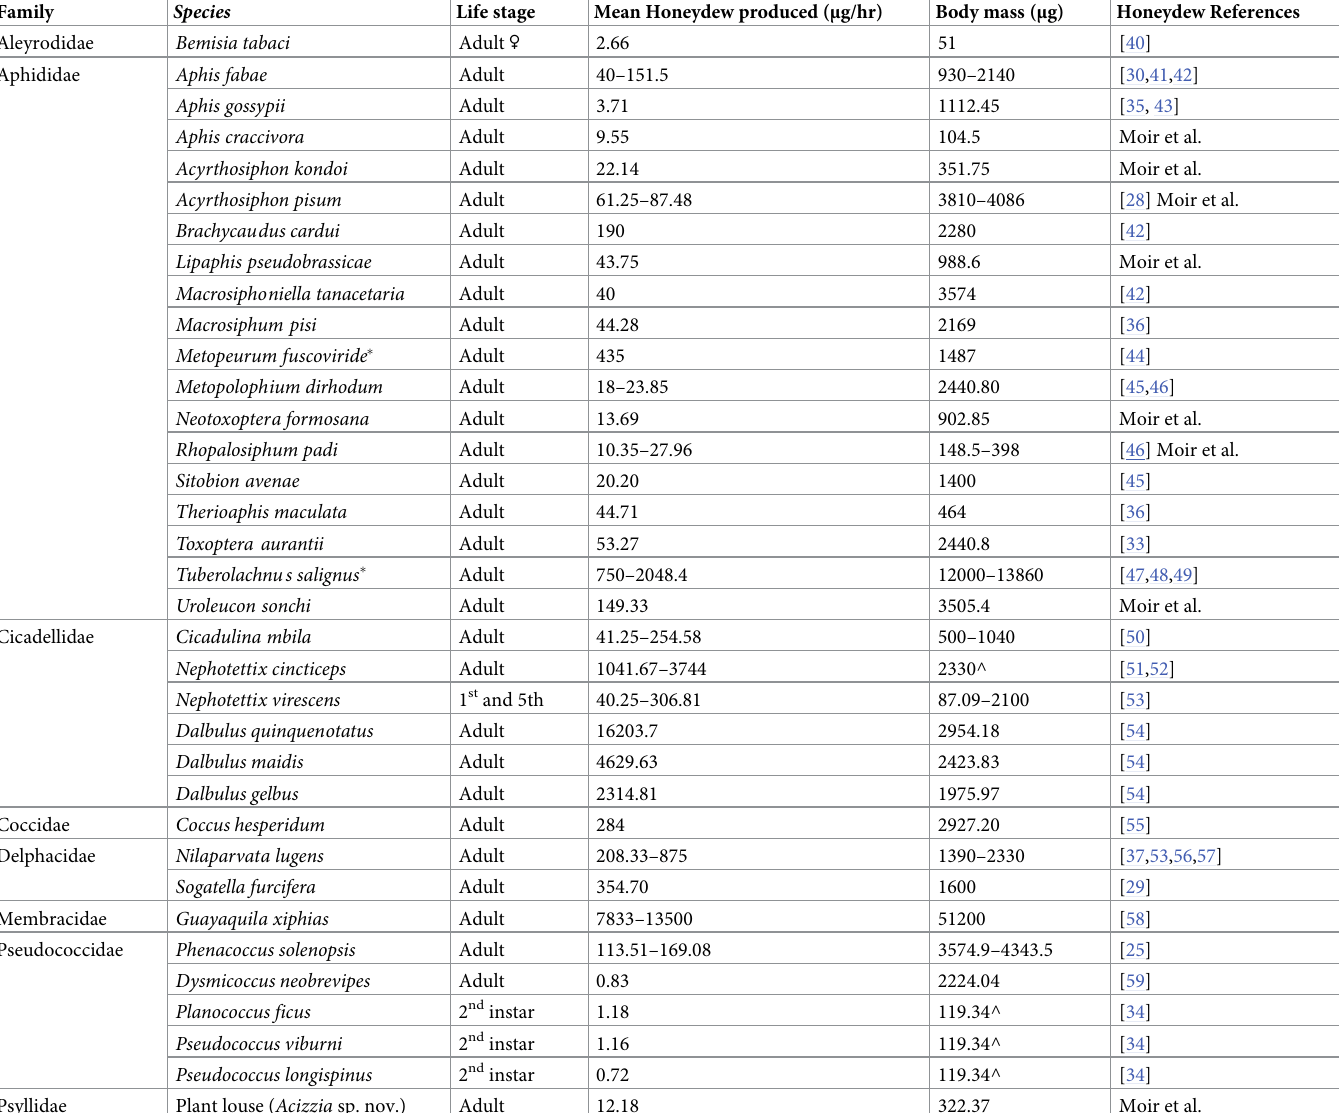
Table 1. Collation of honeydew production in adults of different hemipteran species (except when adult data was not available). Additional details including honey- dew produced by different nymphal stages, attending ants, host plants, variation (standard error) in honeydew production and source of data within each reference is given in S1 Appendix when